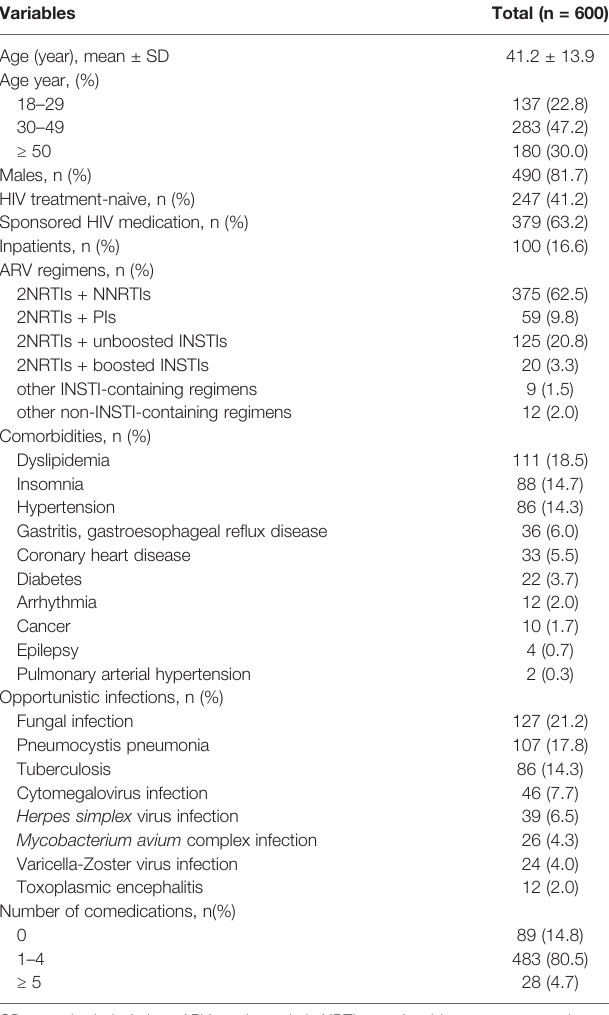
SD, standard deviation; ARV, antiretroviral; NRTIs, nucleoside reverse transcriptase inhibitors; NNRTIs, non-nucleoside reverse transcriptase inhibitors; PIs, protease inhibitors; INSTIs, integrase inhibitors. Comedications was de fi ned as the use of non-HIV